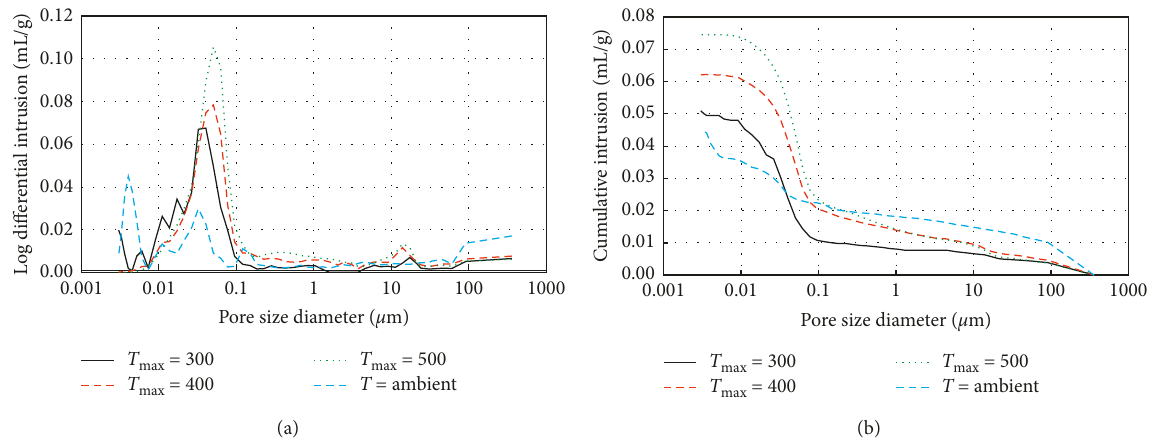
Figure 17: Pore size distributions of the UHPC specimens before and after exposure to thermal cycling (F10 series specimens). (a) Differential pore volume. (b) Cumulative pore